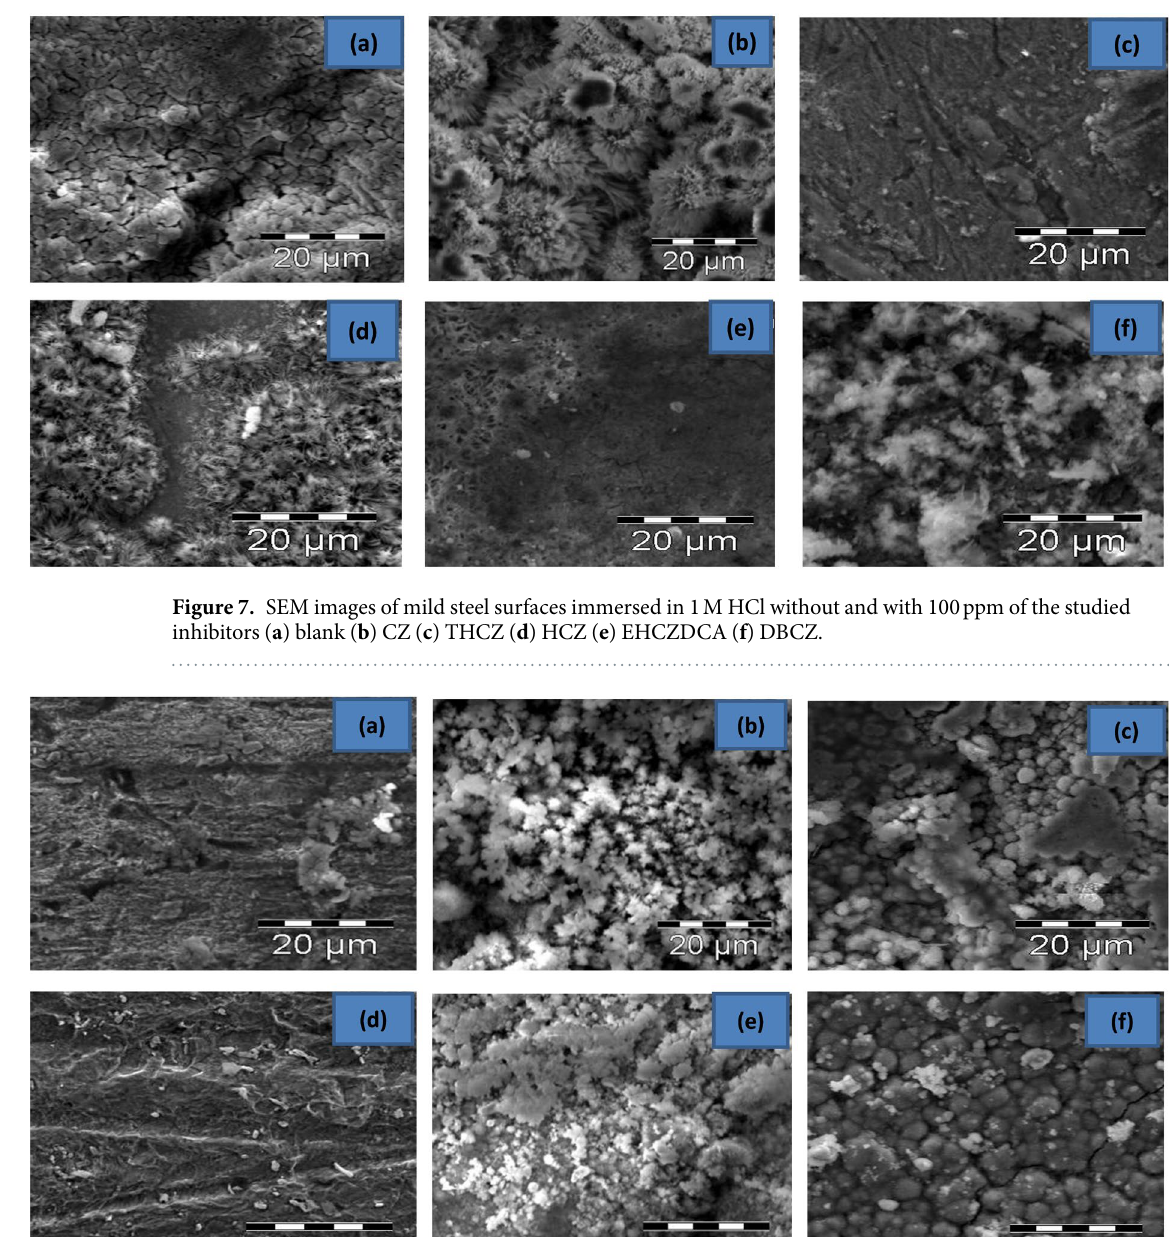
orbitals has been the major molecular and electronic explanation behind the adsorption of inhibitor molecules on metallic surface.